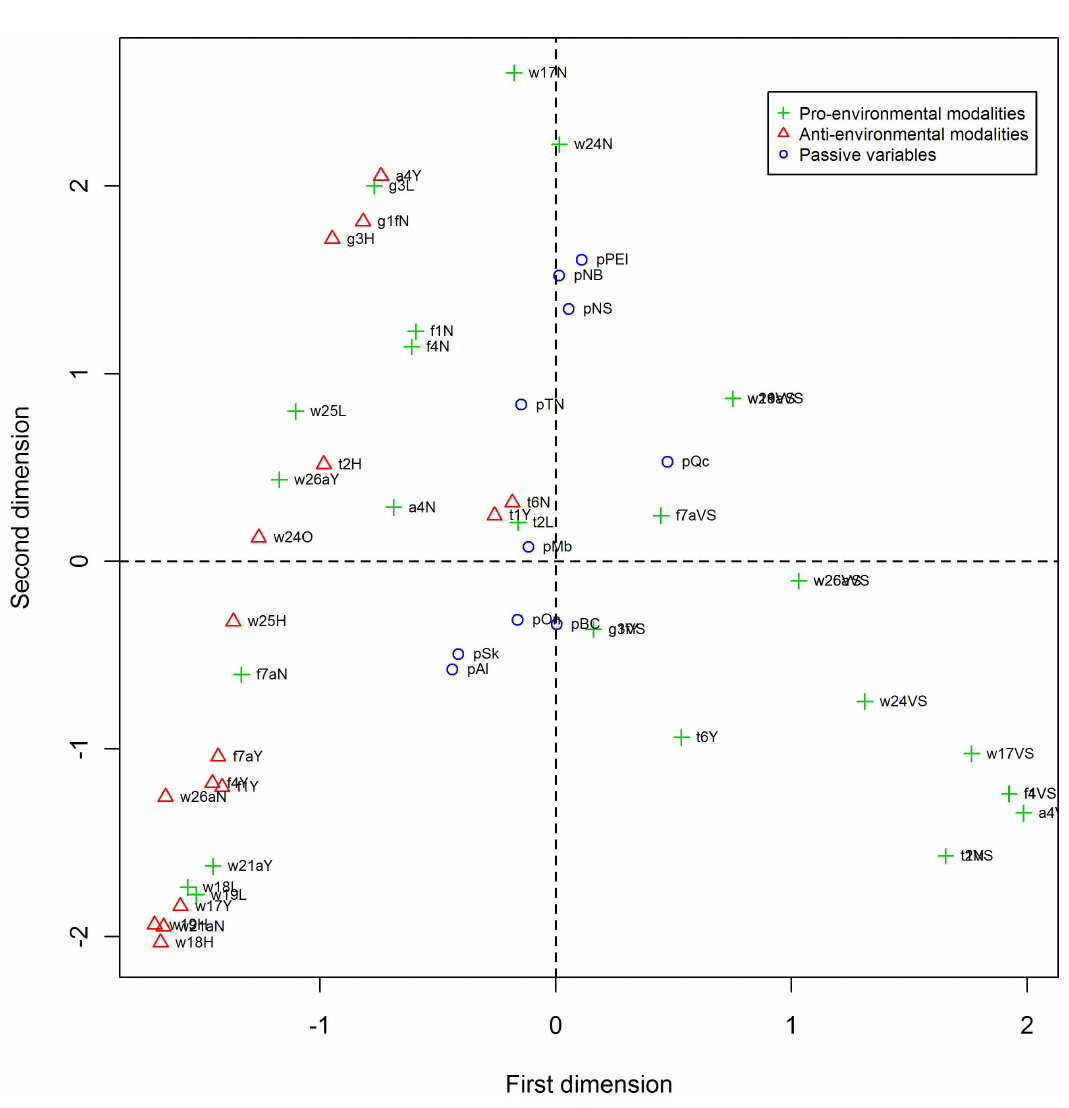
Table 2. Explained inertia by each dimension for group B: Outdoor Index, 2007.